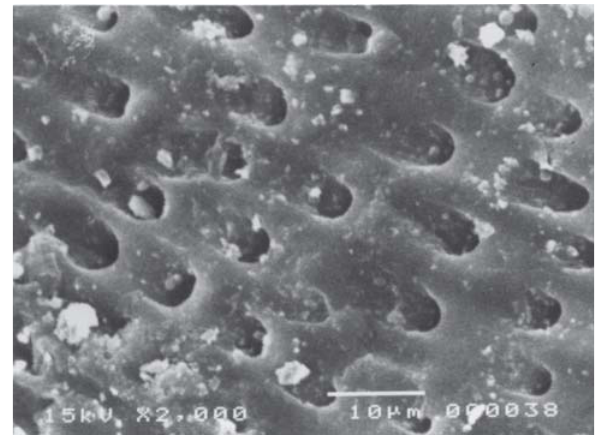
FIGURE 4- SEM micrograph of adhesive failure (G-IV – 2000x) TABLE 2- Bond strength means (MPa) with and without application of bioactive glass